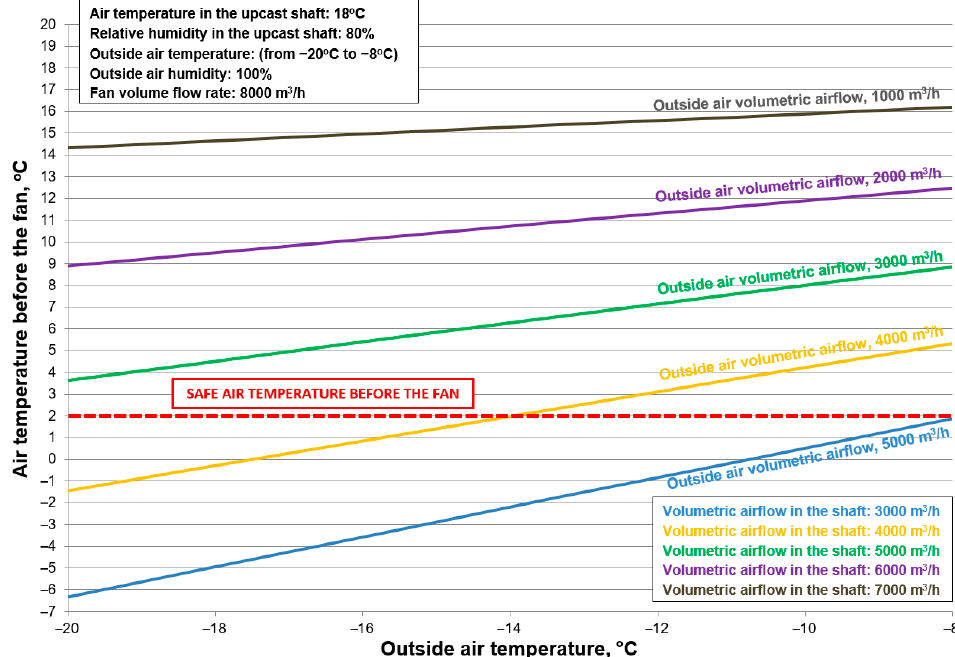
Figure 5. Opportunities to increase external losses at an upcast shaft in the